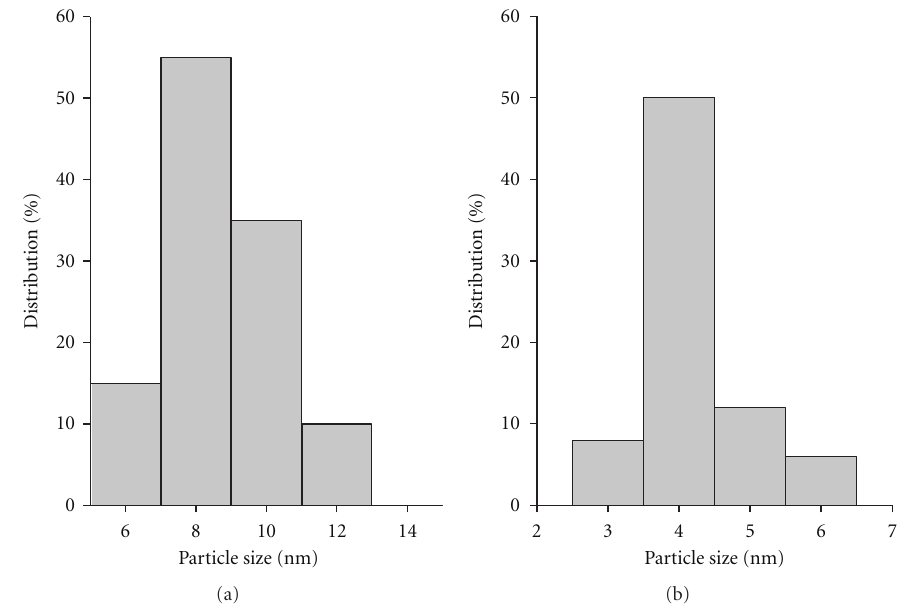
Figure 6: Size distribution diagrams of Au metal obtained from the TEM images of PAD-Au/Ti-HMS (a) and img-Au/Ti-HMS (b) catalyst after H 2 treatment at 473 K.